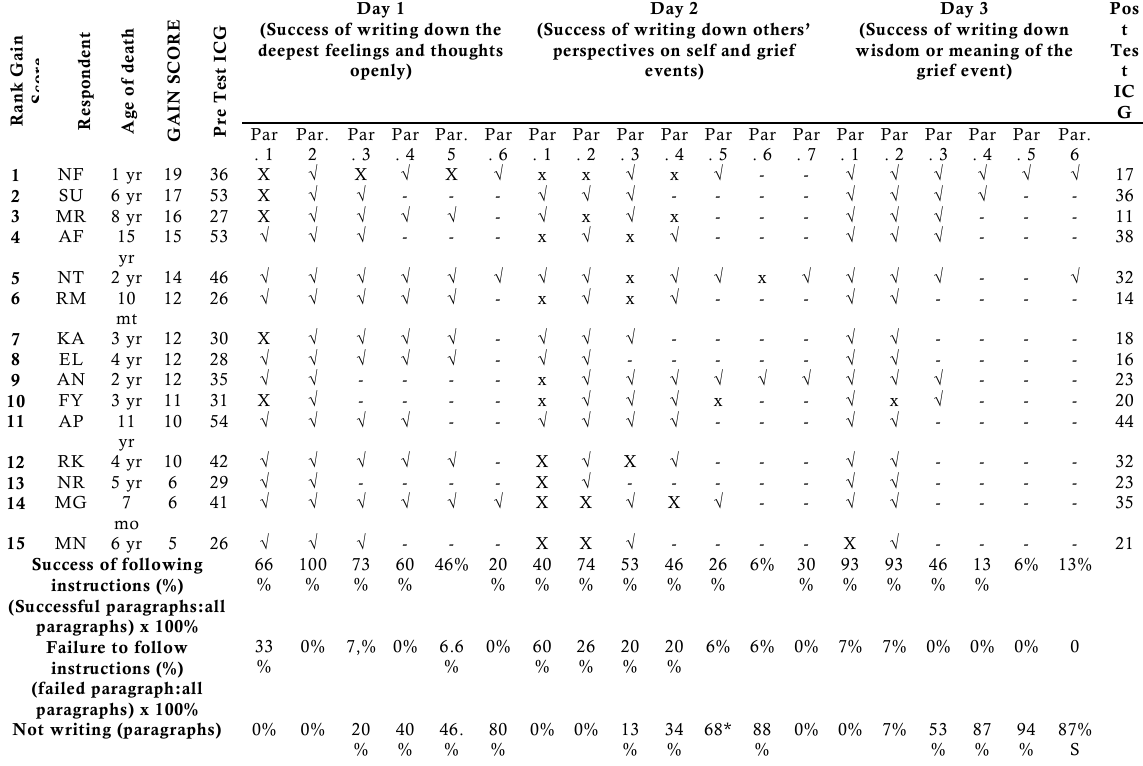
Day 1 (Success of writing down the deepest feelings and thoughts